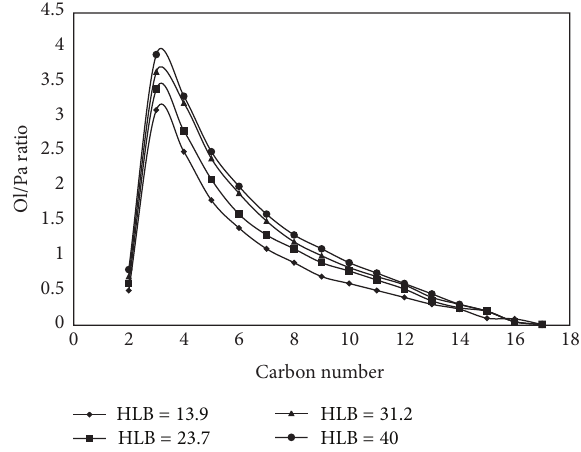
Figure 7: Olefin-to-paraffin ratio in products after 35 h time-on- stream, reaction conditions: 583 K, 17 bar, ( H 2 / CO ) space velocity of 4.9 nl ⋅ h −1 ⋅ g (c) HLB = 31.2, and (d) HLB =